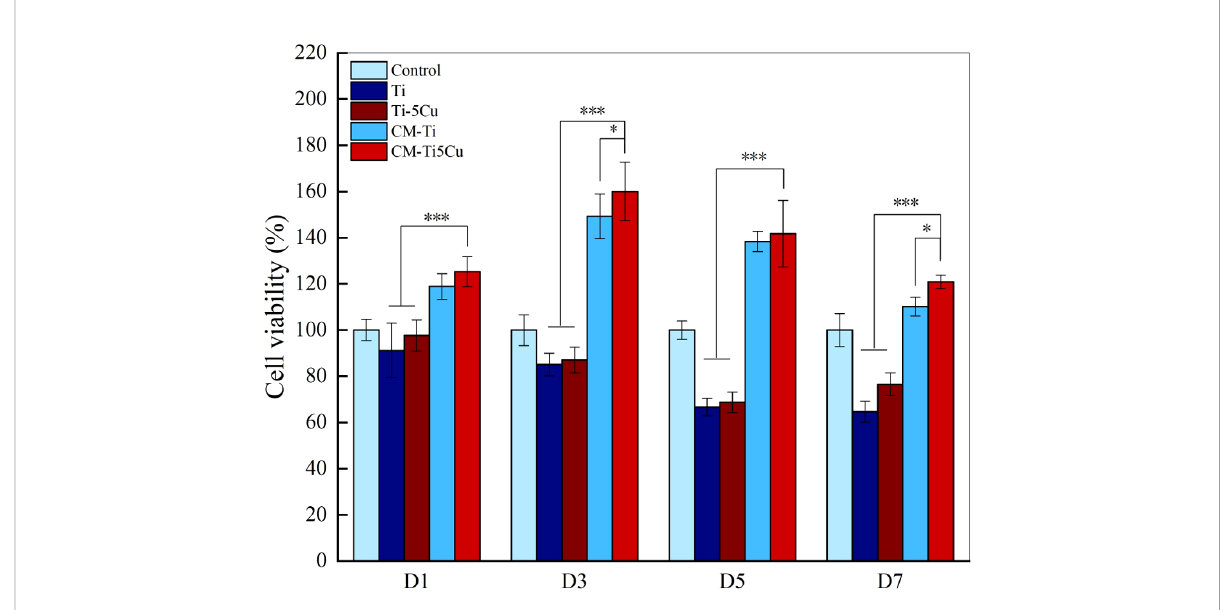
FIGURE 8 The cell viability of MC3T3-E1 cells cultured with conditioned medium and material extracts at D1, D3, D5, and D7, respectively (n = 4; *p < 0.05, ***p <